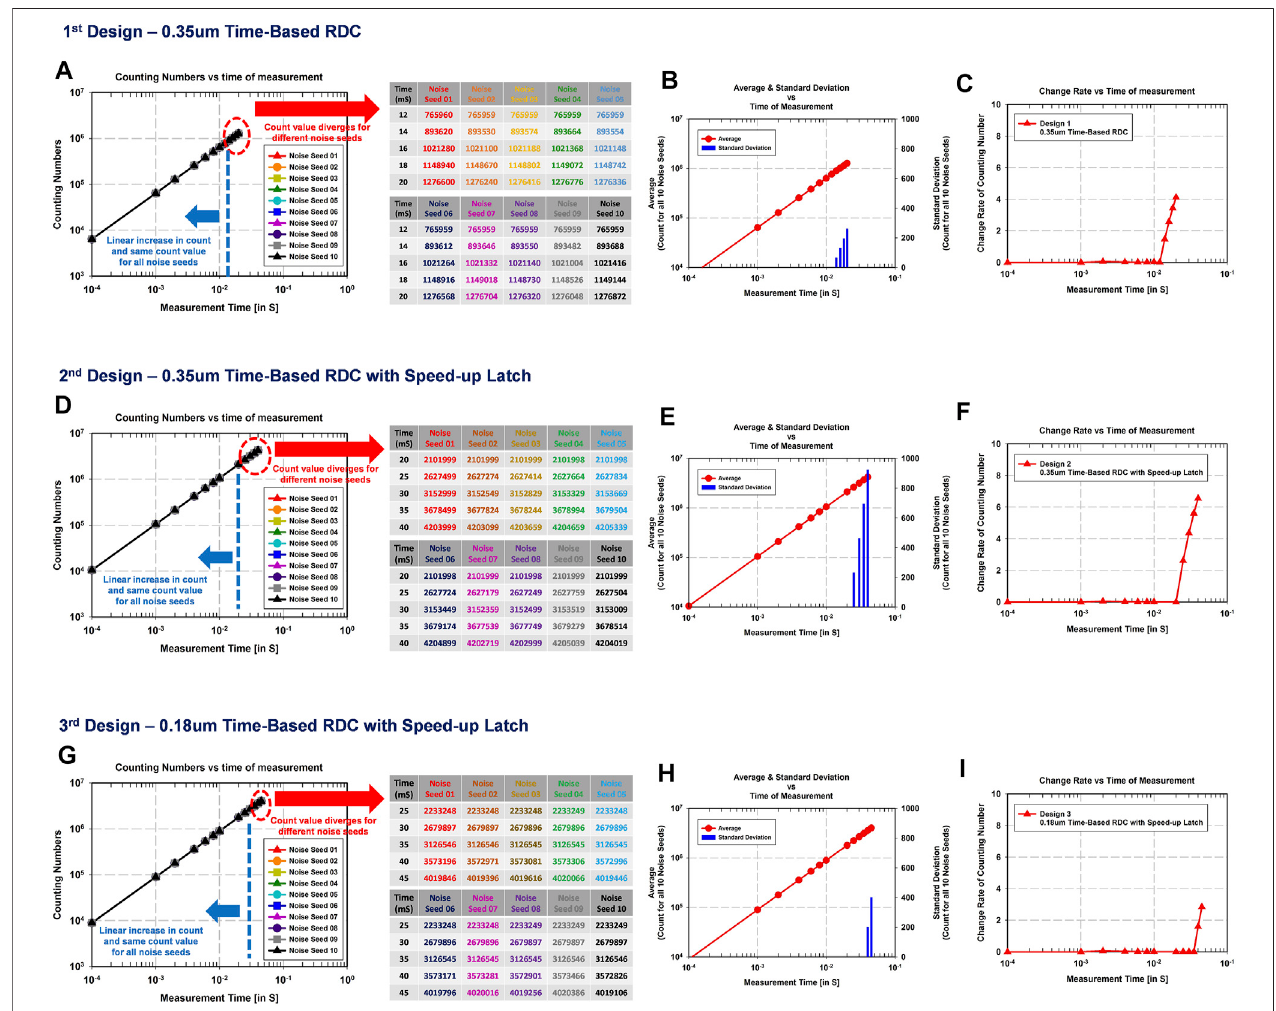
FIGURE 9 | System-level simulation results for the time-based RDC: (A) 10 individual counting numbers obtained from the rising edges of output for the 0.35- μ m time-basedRDC(design1), (B) averageandstandarddeviationofcountingnumbersforall10noiseseeds(design1), (C) changerateofthecountingnumber(design1), (D) 10 individual counting numbers obtained from the rising edges of output for simulation of the 0.35- μ m time-based RDC with the speed-up latch (design 2), (E) average and standard deviation of counting numbers for all 10 noise seeds (design 2), (f) change rate of the counting number (design 2), (G) 10 individual counting numbers obtained from therising edges ofoutputforsimulationofthe0.18- μ m time-based RDCwith thespeed-uplatch (design 3), (H) averageand standarddeviation of counting numbers for all 10 noise seeds (design 3), and (I) change rate of the counting number (design 3).